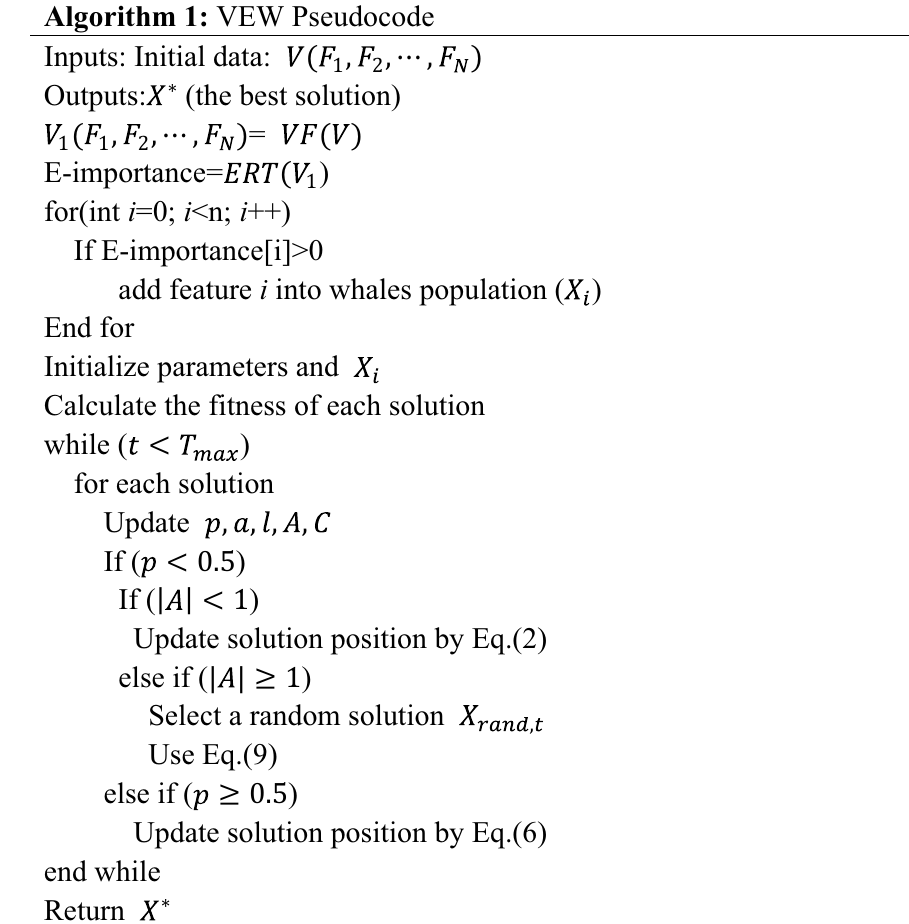
Algorithm 1: VEW